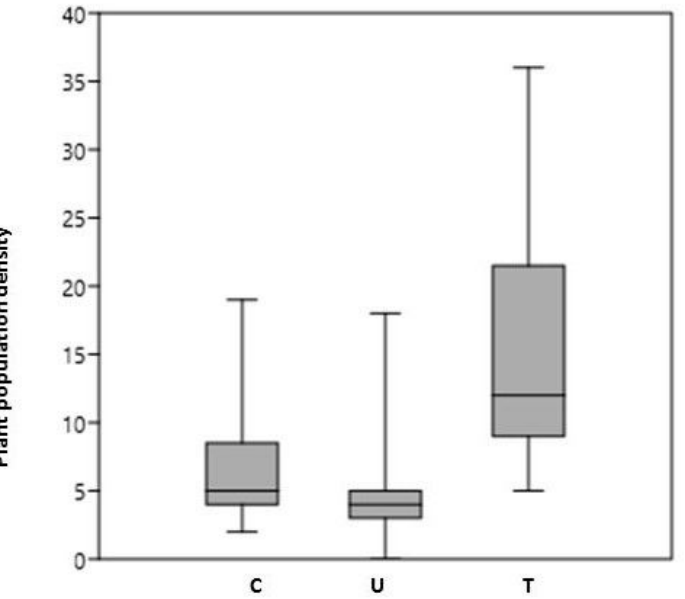
Figure 3. Influence of the managements (Uncultivated: U, Control: C, and Treated: T) on plant population density.